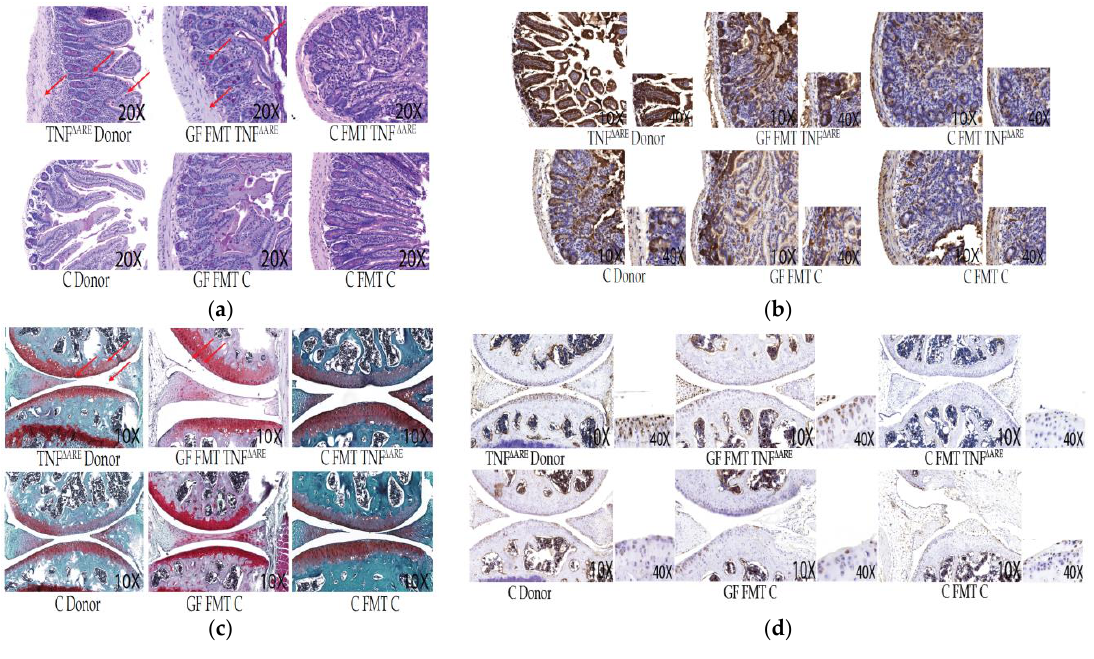
Figure 2 . Descriptive histopathology and immunohistochemistry. Our data shown are representative of ~90% of similar results in FMT mice Panel ( a ) — Histological intestinal sections. Representative images were obtained at 10× magnification as indicated and stained with Periodic Acid Shiff (PAS). Arrows represent thickening of the wall and disorganization, blunting of the villi and cell infiltrations. GF mice FMT with C donor and conventional C mice do not display histological dif- ferences or pathology. GF mice FMT with TNF ΔARE+/− donors exhibit similar histopathology to the donors themselves. Panel ( b ) — Intestinal immunohistochemistry sections. Representative images were obtained at 10× magnification as indicated. Slides were stained with anti-TNF polyclonal anti- body. Massive TNF production is observed in TNF ΔARE+/− donor intestines and GF mice FMT with TNF ΔARE+/− donors compared to their control counterparts. Enlargement of the intestinal epithelial cell layer at 40× magnification indicates that TNF production is localized in epithelial cells in TNF ΔARE+/− donors and GF FMT with TNF ΔARE+/− donors. Other immunohistochemistry cuts display a normal baseline level of TNF, not localized in the epithelial cells. Panel ( c ): Histological knee sec- tions. Representative images were obtained at 10× magnification as indicated and stained with Saf- ranin’O/light green. TNF ΔARE+/− donor sections and GF mice FMT with TNF ΔARE+/− donors show fea- tures of joint degradation indicative of arthritis: Arrows point out clefts, debris, tears and loss of glycosaminoglycans. These features are not observed in controls, C donors, GF FMT with C donors and C mice FMT with either donors. Panel ( d ): Knee immunohistochemistry sections. Slides were